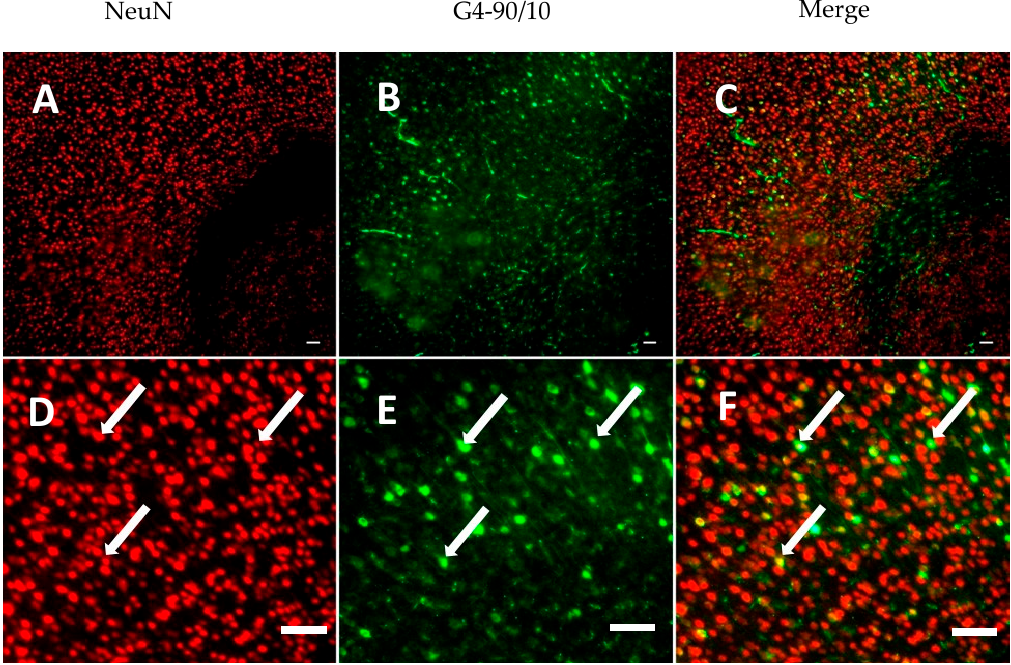
Figure 10. ( A ) Nucleus stained with NeuN antibody (red); ( B ) uptake of G4-90/10 dendrimers by the neurons in the cortex 1-week post intracranial transplantation; ( C ) Co-localization between NeuN and dendrimers showing uptake of dendrimers by the neurons; ( D – F ) show the zoomed images of ( A – C ), respectively. Arrows in D shows neurons expressing NeuN; arrows in E shows uptake of G4-90/10 dendrimers by the neurons and arrows in F shows co-localization between the dendrimers and NeuN staining that confirms the uptake of dendrimers by neurons. Images ( top panel ) were taken at 20× magnification using Zeiss Observer inverted Microscope (Zeiss, Oberkochen, Germany). Scale bar: 100 μ m.